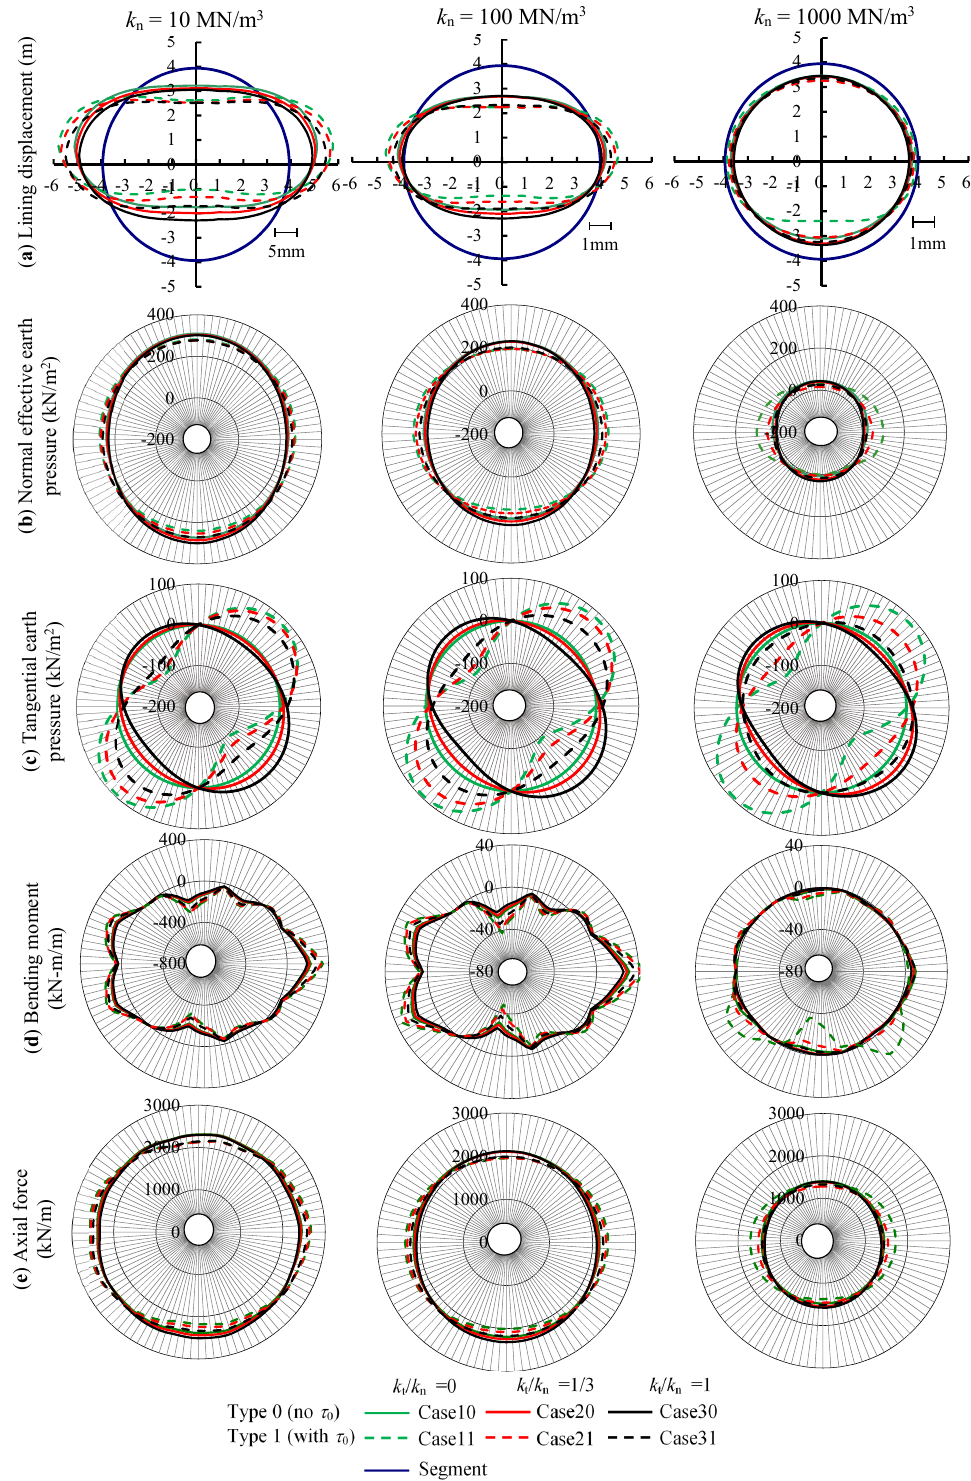
Figure 7. Lining displacement and ground reactions (deep tunnel).